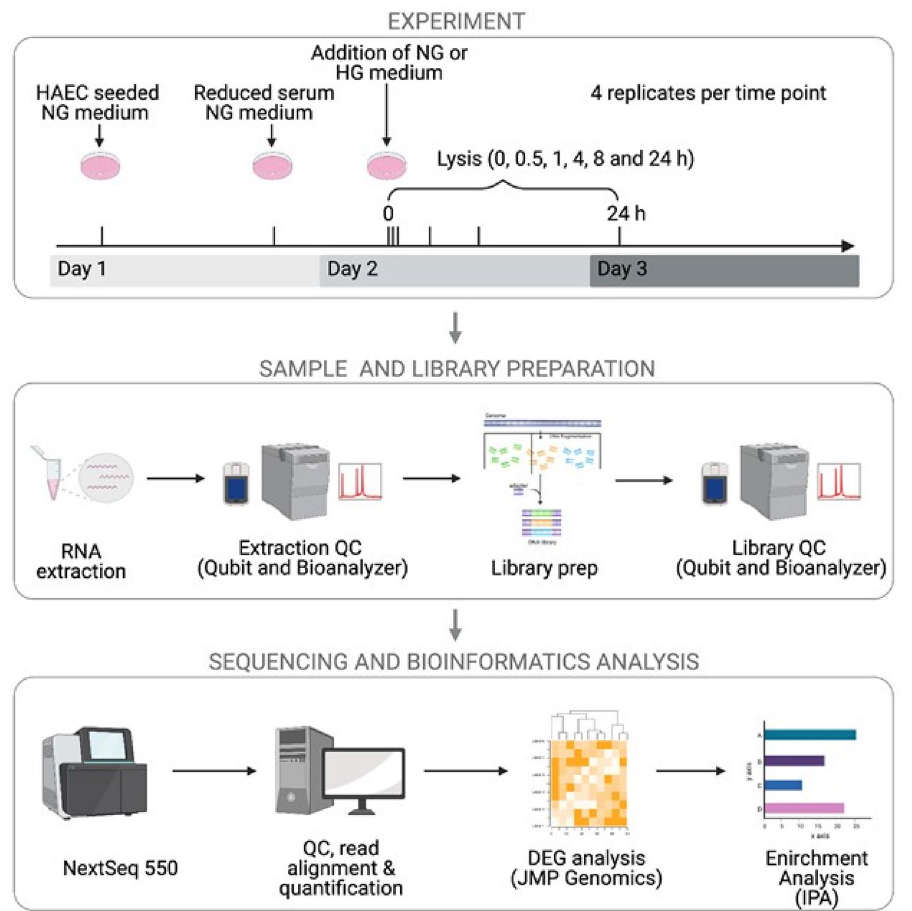
Figure 1. Schematic of time-series RNA-seq experimental design. Post overnight exposure to reduced serum medium, HAECs were treated with either NG (5.5 mM d-glucose) or HG (25 mM d-glucose) for 0.5, 1, 4, 8 and 24 h. Sample and library preparation was followed by NextSeq 550 sequencing and bioinformatics analysis. Figure created with